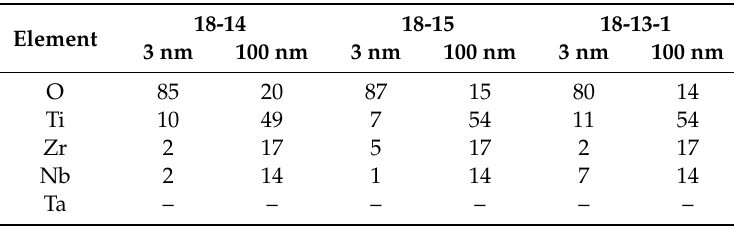
Table 3. Surface elemental compositions of the 18-14, 18-15, and 18-13-1 alloys at different analysis depths (atom %); before exposure to Hanks’ solution.